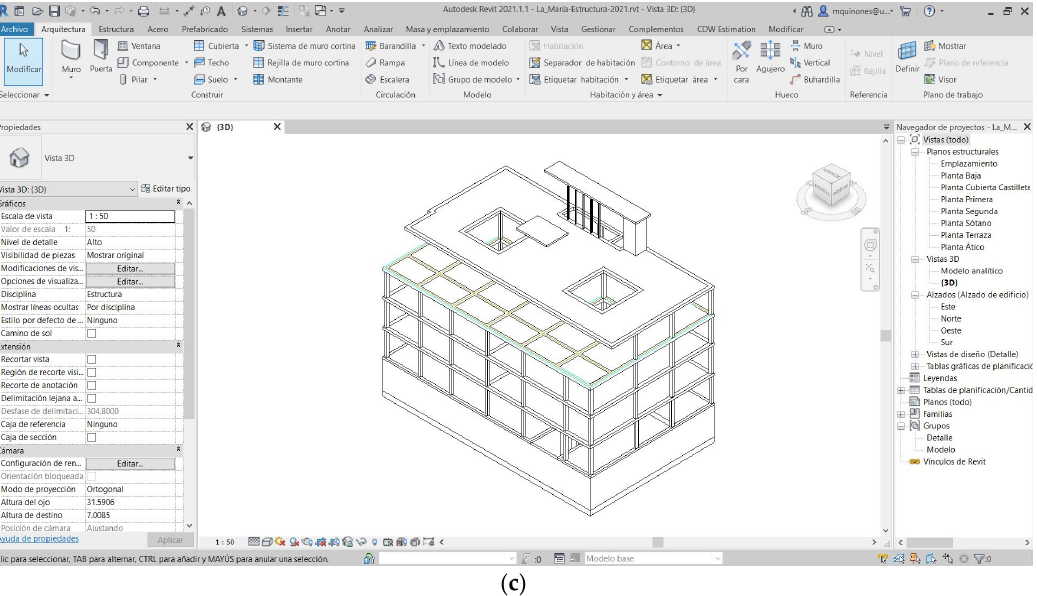
Figure 6. Structure system modelled in BIM: ( a ) Allplan; ( b ) Archicad; ( c ) Revit. Table 4. Features of new residential buildings in Spain